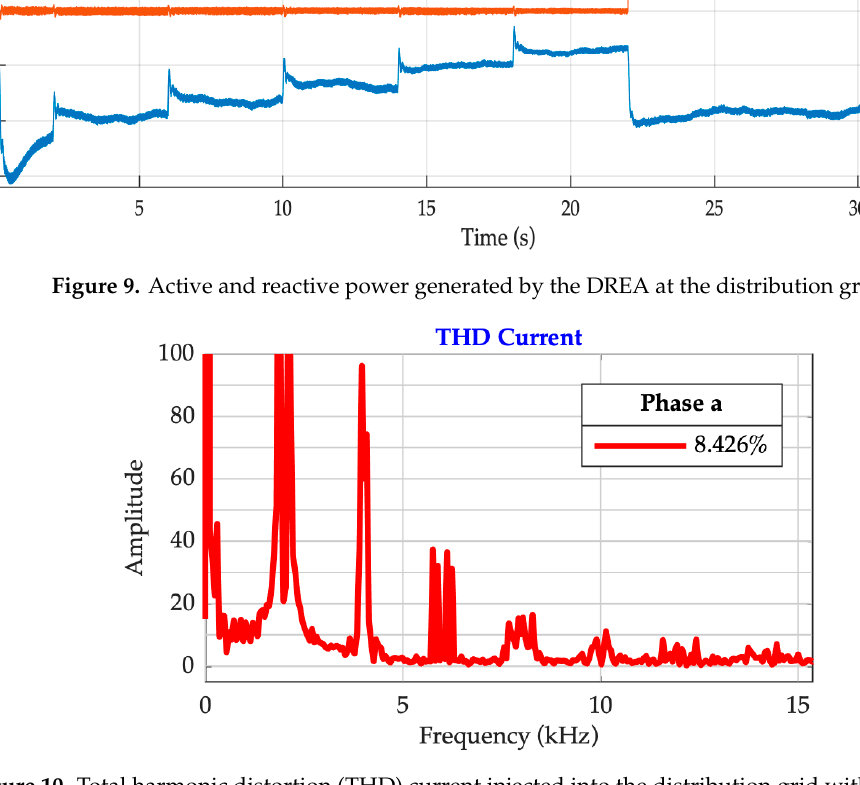
Figure 9. Active and reactive power generated by the DREA at the distribution grid.